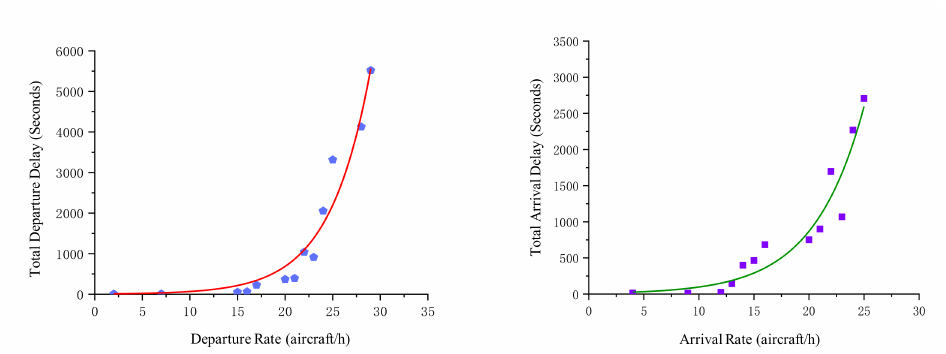
Figure 7. The relationship between runway throughput and delay at ZSNJ.